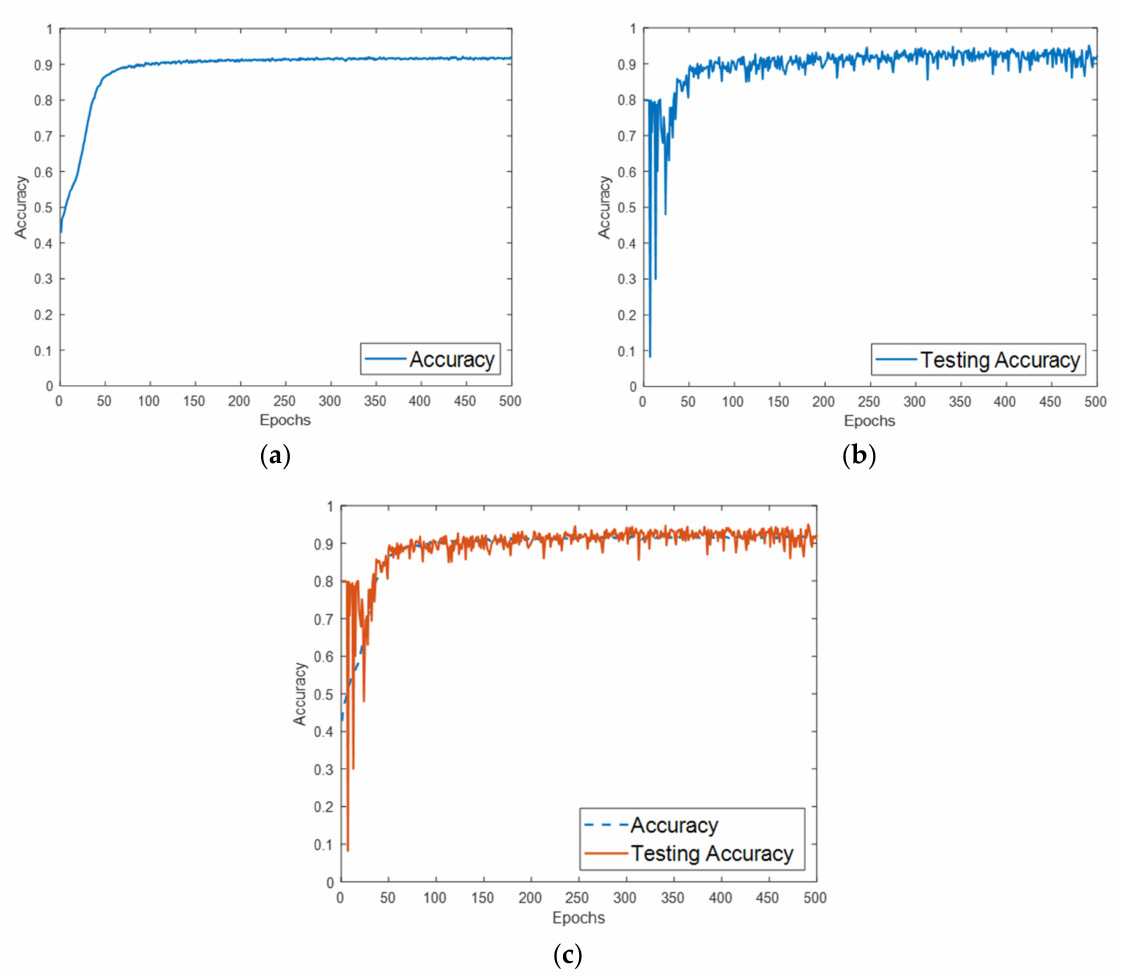
Figure 9. ResNet performance training with invariant database: ( a ) training accuracy curve; ( b ) testing accuracy curve; ( c ) comparison between accuracy and testing accuracy curves.